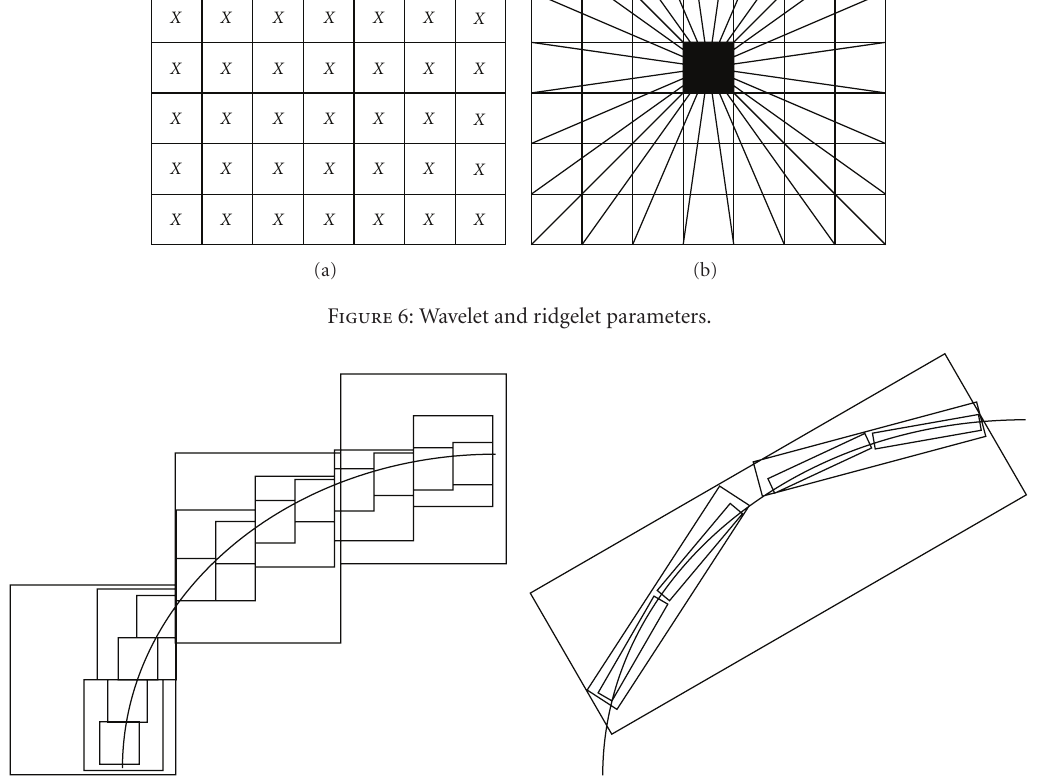
Figure 7: An approximating comparison between wavelet (a) and curvelet